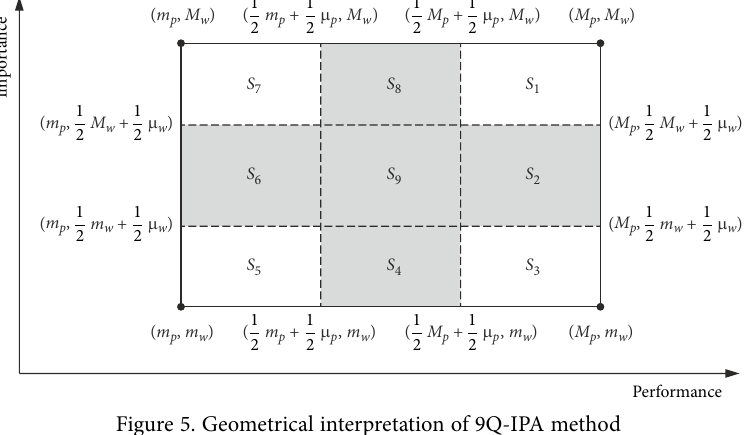
Figure 5. Geometrical interpretation of 9Q-IPA